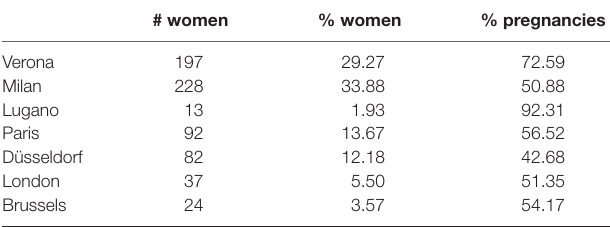
Table 6 | Number and percentage of women and percentages of pregnancy for the women enrolled in each of the NFP centers.